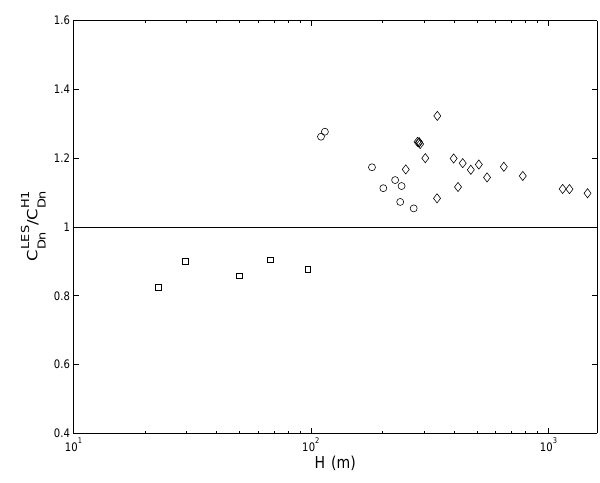
/C H 1 Fig. 7. The dependence of C LES on the PBL depth H . C H 1 Dn Dn Dn is given by Eq. (15). Symbols and lines are the same as in Fig.